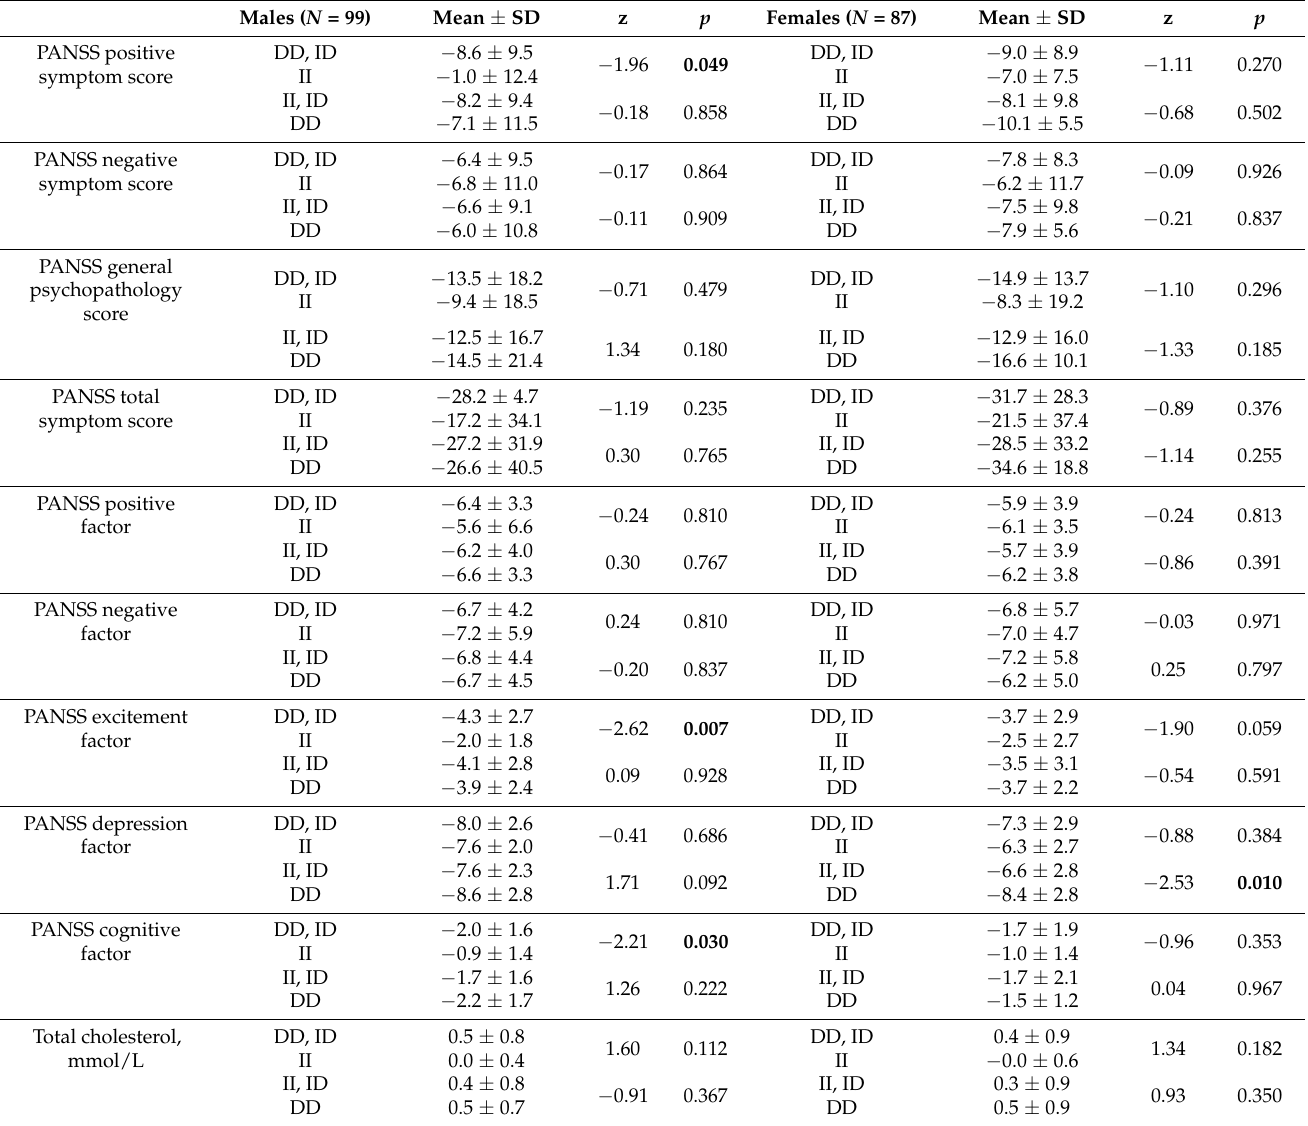
Table 3. PANSS psychopathology data and metabolic-syndrome-related parameters upon antipsy- chotic treatment according to ACE-I/D